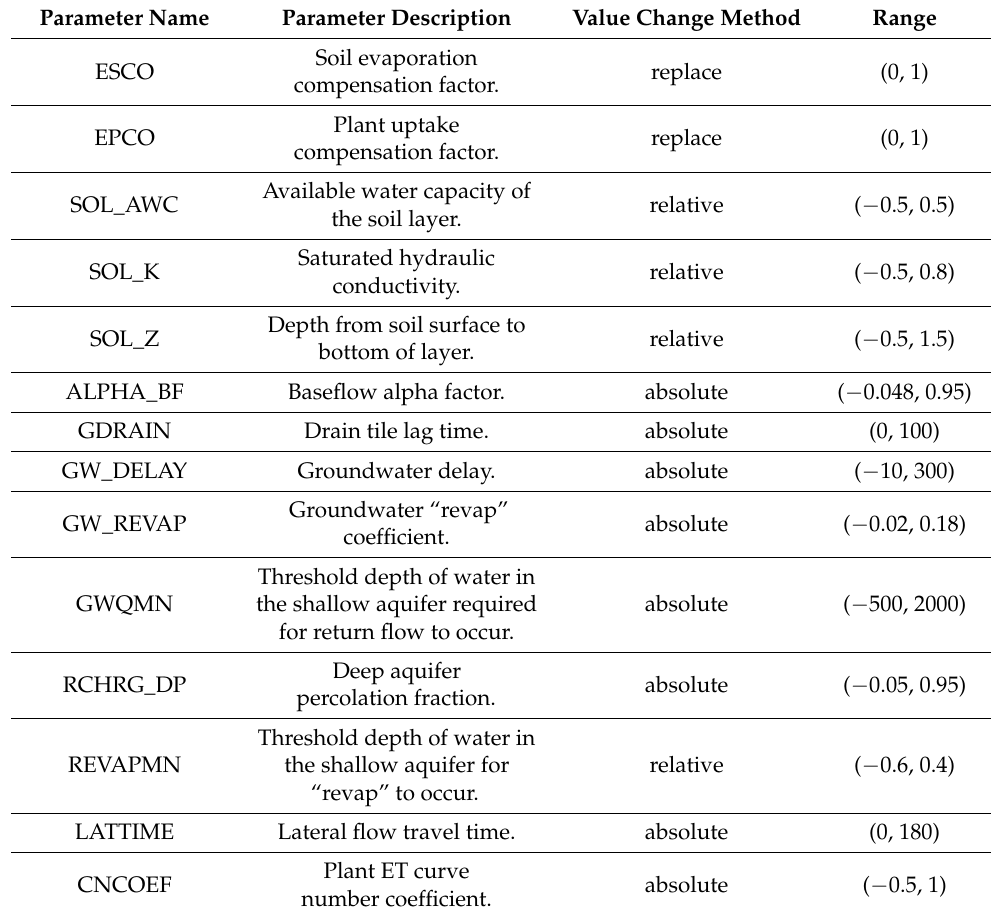
Table 1. The more sensitive parameters of the model and their ranges as they resulted by the sensitivity